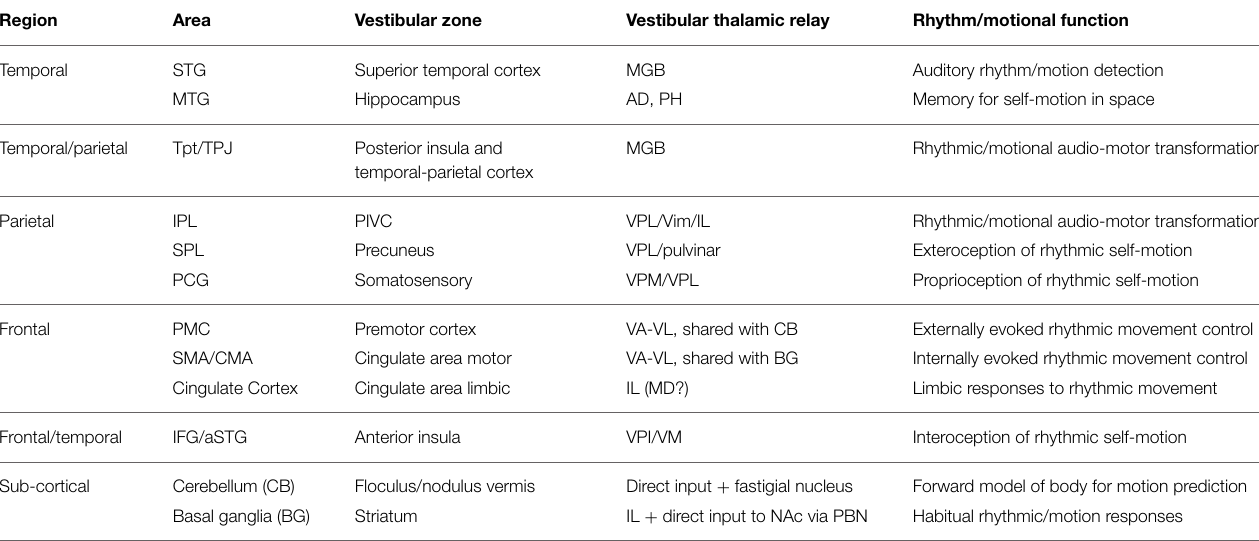
TABLE 1 | Summary of areas and putative role (internally vs. externally referenced), with routes for cochlear vs. vestibular input (thalamus).